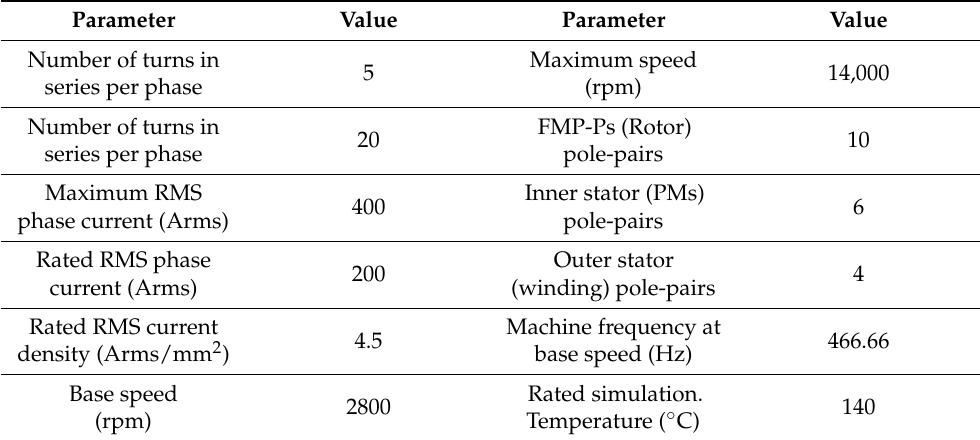
Table 12. Identical parameters among four designs.